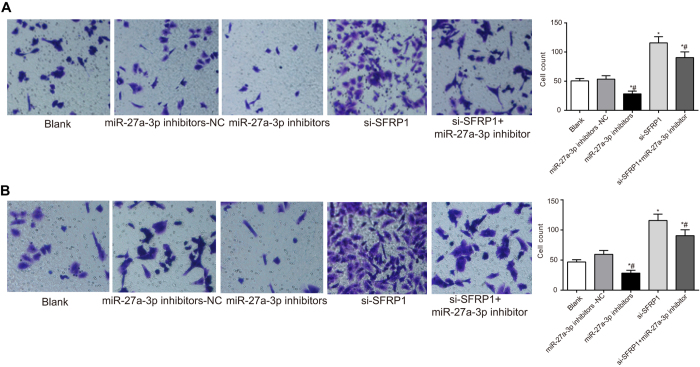
The invasion ability of OSCSCs in the miR-27a-3p inhibitors, miR-27a-3p inhibitors-NC, si-SFRP1, si-SFRP1 + miR-27a-3p inhibitors and blank groups detected by a Transwell assay after transfection (400×).(A) The Transwell images and histogram showing the invasion of SCC-9 OSCSCs in the five groups. (B) The Transwell images and histogram showing the invasion of Tca8113 OSCSCs in the five groups. *Represents P < 0.05 comparisons with the blank and miR-27a-3p inhibitors-NC groups. #Represents P < 0.05 comparisons with the si-SFRP1 group. OSCSCs, oral squamous carcinoma stem cells.